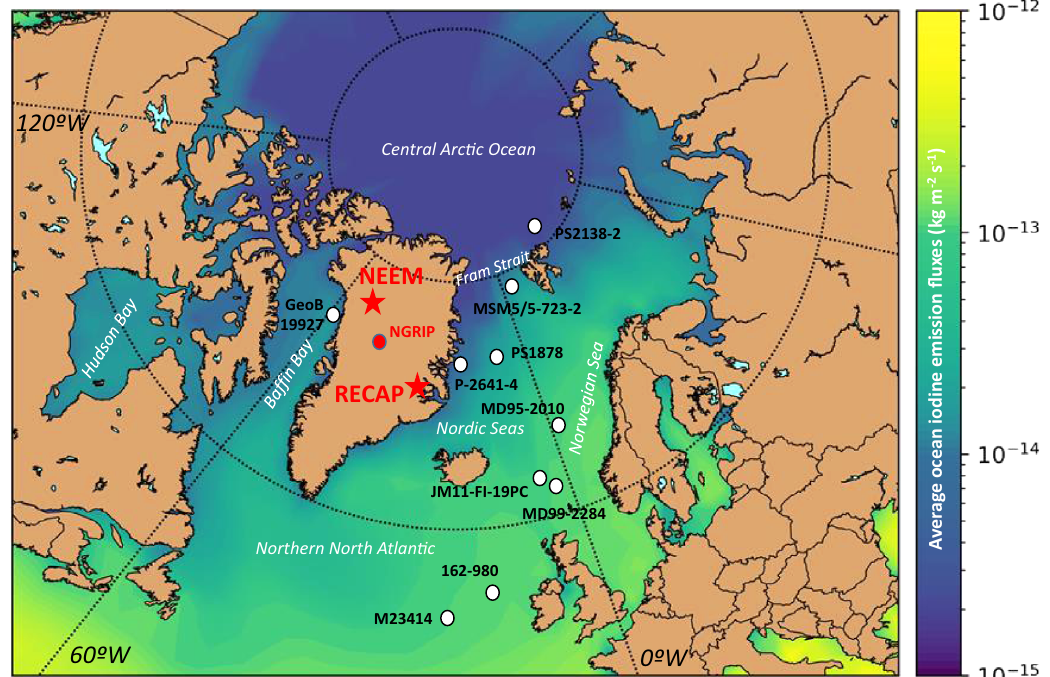
Fig. 1 Present-day (CE 2014) total iodine emission fl uxes from the oceanic regions in fl uencing Greenland. Modelled mean annual total iodine emission fl uxes (CH + CH + CH + CH + HOI + I 3 I 2 I 2 2 IBr 2 ICl 2 ) from the North Atlantic and Arctic Oceans using the 3D chemistry-climate model CAM-Chem. The fi gure includes the location of the NEEM and RECAP ice cores (red) and other ice cores and marine paleoceanographic archives in the Arctic and the northern North Atlantic discussed in the text and fi